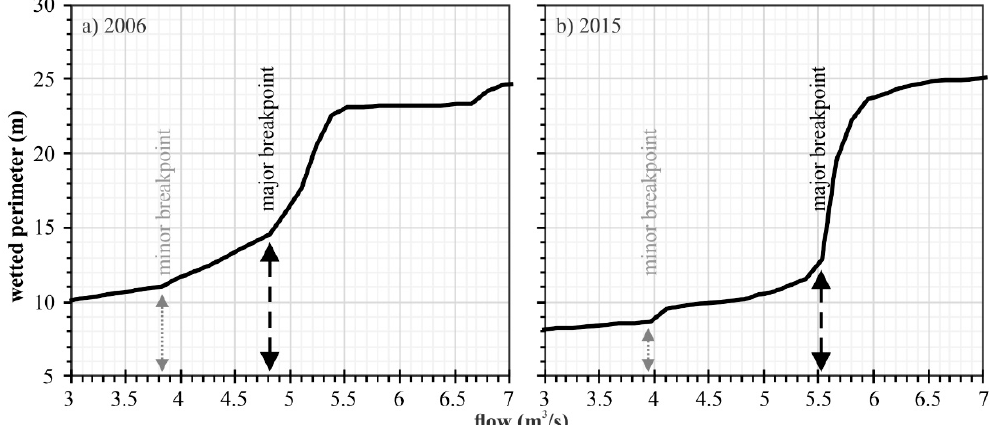
Figure 5. The geomorphic bankfull capacity enlarged from a pre-hydrologic modification flow of about 3.9 m 3 /s to a post-hydrologic modification flow of about 4.8 m 3 /s during the ( a ) 2006 baseline survey and about 5.5 m 3 /s during the ( b ) repeat survey.